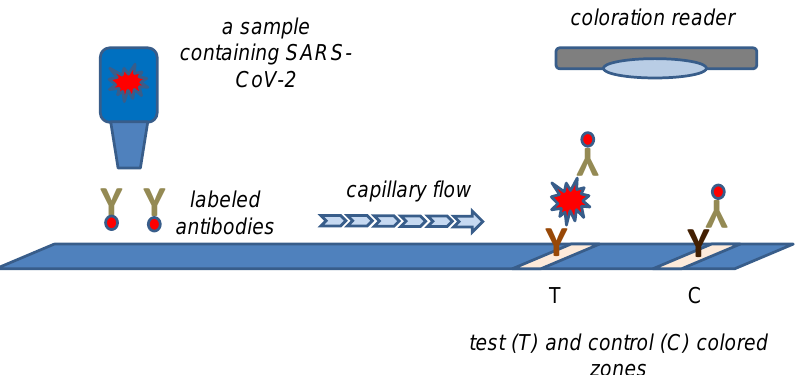
Figure 4. A biosensor based on the principle of the lateral flow test with coloration reader to measure color density.